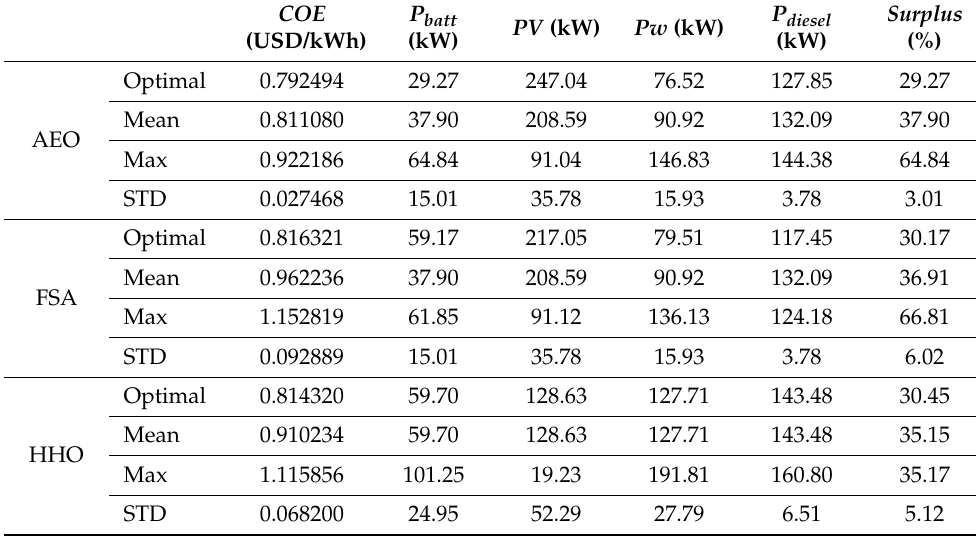
Table 6. Optimal, Minimum, Maximum, and STD for AEO, FSA, and HHO with DSM at 60% REF and 0% LPSP.